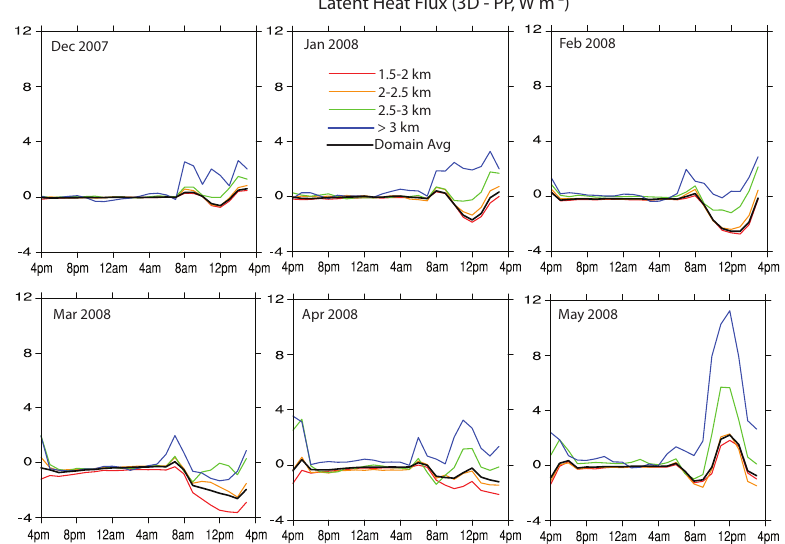
Fig. 7. Same as in Fig. 5, except for the monthly mean domain-averaged diurnal variation time series of latent heat flux.